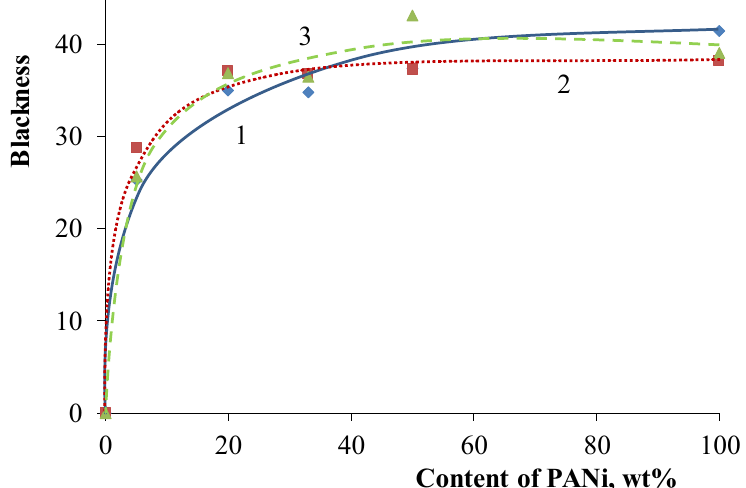
Figure 11. Core/shell pigment blackness vs. PANi content with various cores. The core of the pigment: (1) kaolin; (2) talc; (3) bentonite; (4) muscovite.